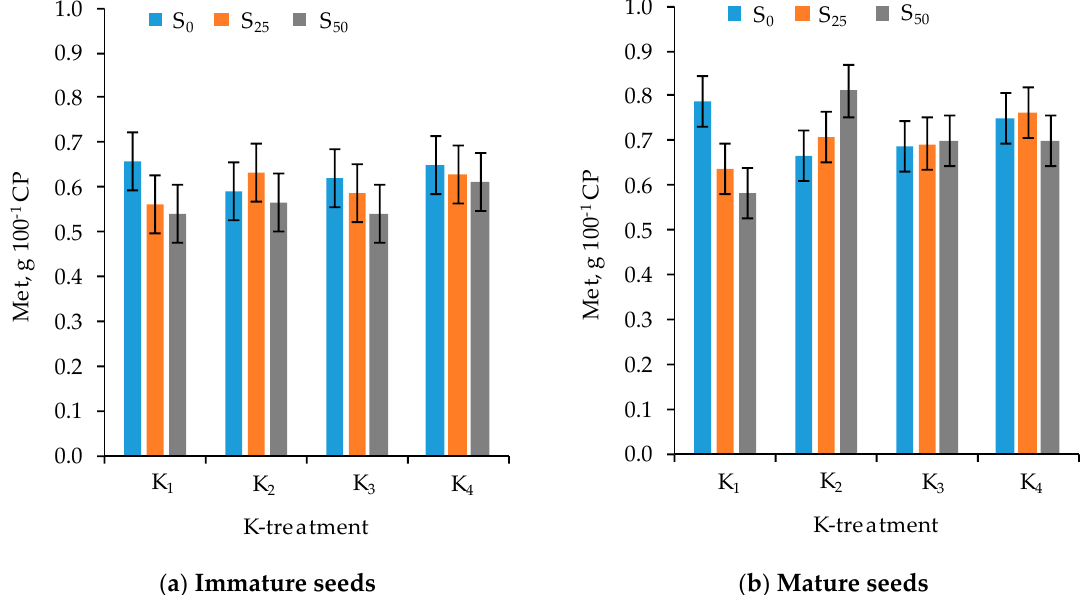
Figure 4. Effect of interaction between K and S application on Met content in: ( a ) immature seeds; ( b ) mature seeds. K 1 , K 2 , K 3 , and K 4 refer to levels of soil K availability and fertilization; S 0 , S 25 , and S 50 refer to sulfur application at rates of 0, 25, and 50 kg S ha − 1 , respectively. Letters indicate significant differences between treatments ( p < 0.05). Hatched bars represent 2 × standard error (SE) ranges.